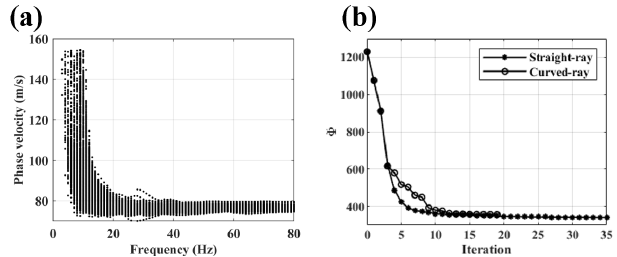
Figure 6. (a) The extracted DCs for the sand bar model and (b) the values of misfit function at different iterations of the